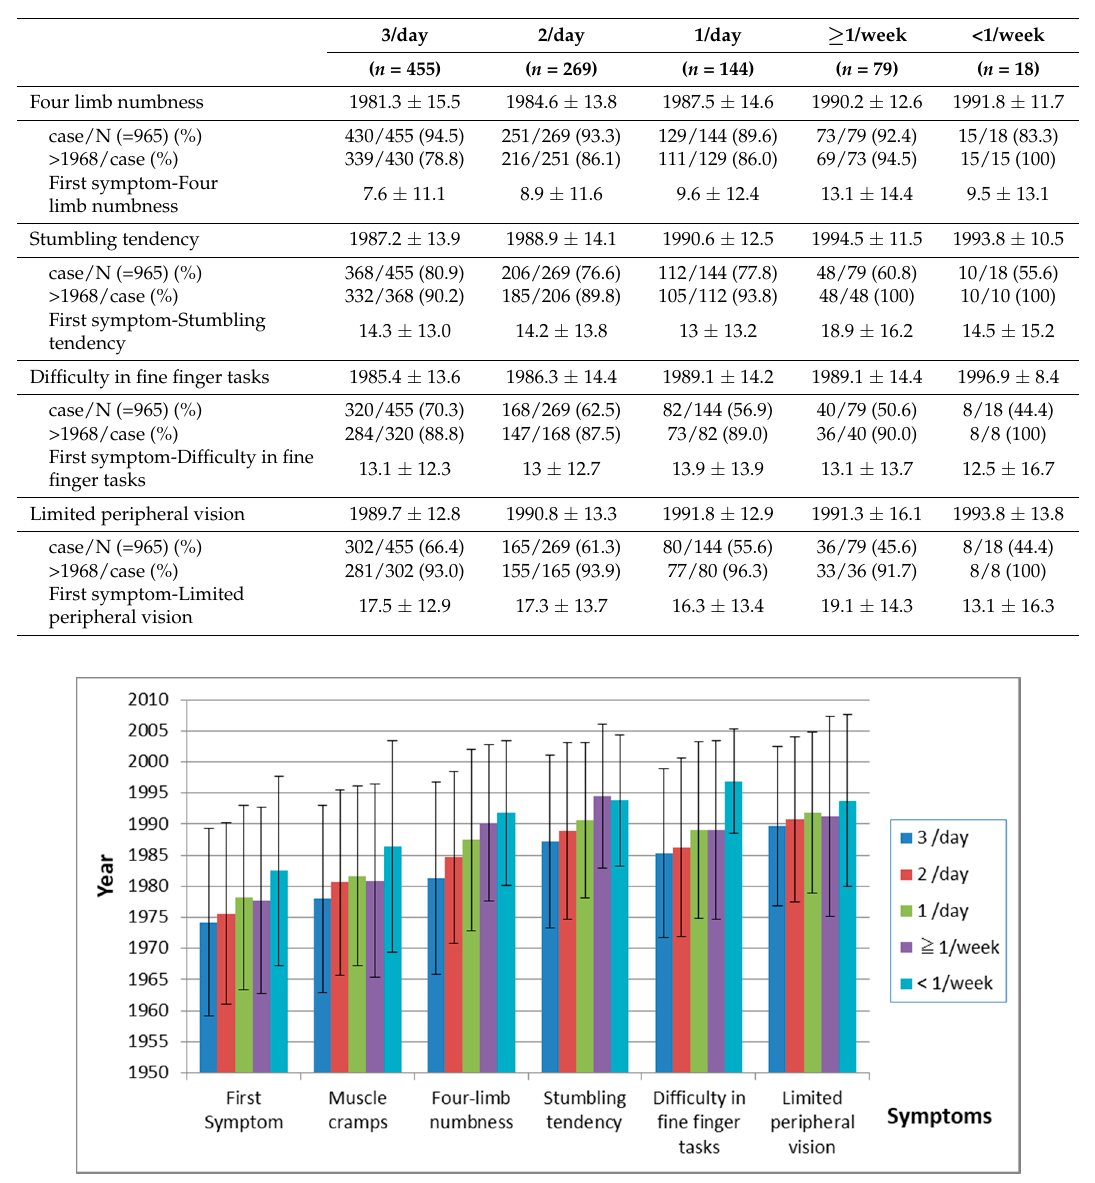
Figure 9. Onset of symptoms and frequency of fish ingestion. The time of onset of subsequent symptoms increased as the frequency of fish ingestion decreased.